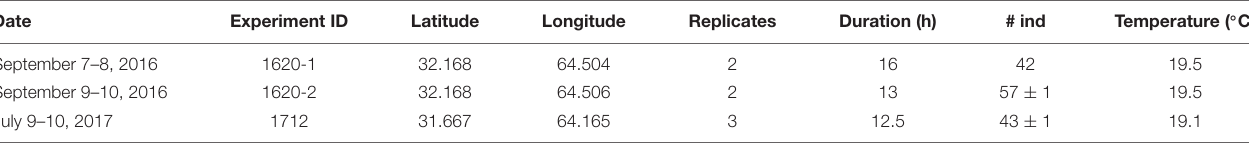
TABLE 1 | Date and location of zooplankton